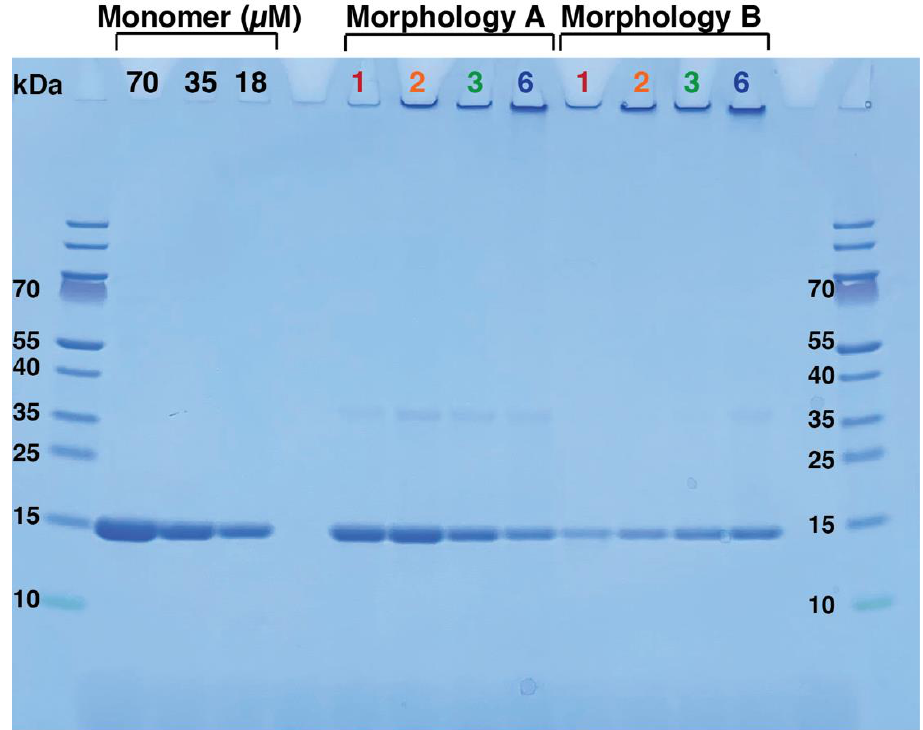
Figure 5. SDS-PAGE containing supernatant of samples seeded with morphology A and morphology B. Aliquots were taken from fresh monomer as well as from seeded sample after incubation for: 1 day; 2 days; 3 days; and 6 days at 37 °C with stirring. Separation of fibrils and monomers was performed as explained in Section 4.8. The first and last well contain Mw standard. For comparison of concentrations, monomeric sample was loaded at three different concentrations, 70 µM, 35 µM and 18 µM (black). Supernatant of samples containing fibrils of morphologies A and B, after 1, 2, 3, and 6 days incubation are shown in red, orange, green and blue, respectively. The quantification of α -synuclein concentration in these samples using isotope standard and MALDI mass spectrometry after digestion with trypsin are shown in Figure S7.